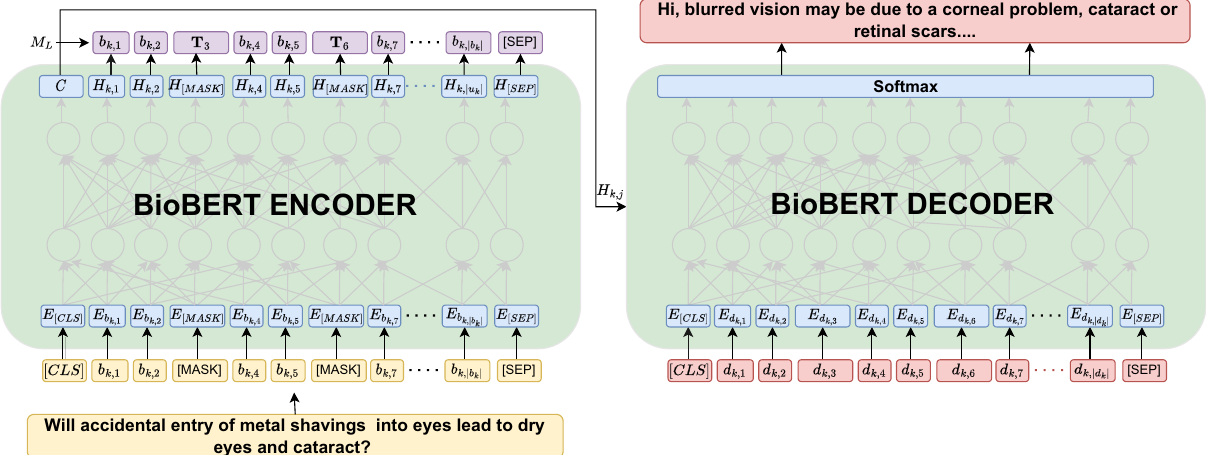
Figure 2. MED architecture: The proposed architecture first encodes the conversation history using a BioBERT encoder as shown in the left. We first attempt to predict the sequence M L using the token classification task that provides the hidden states, H k , i , for the input sequence. This input sequence is then fed into a BioBERT decoder to generate the